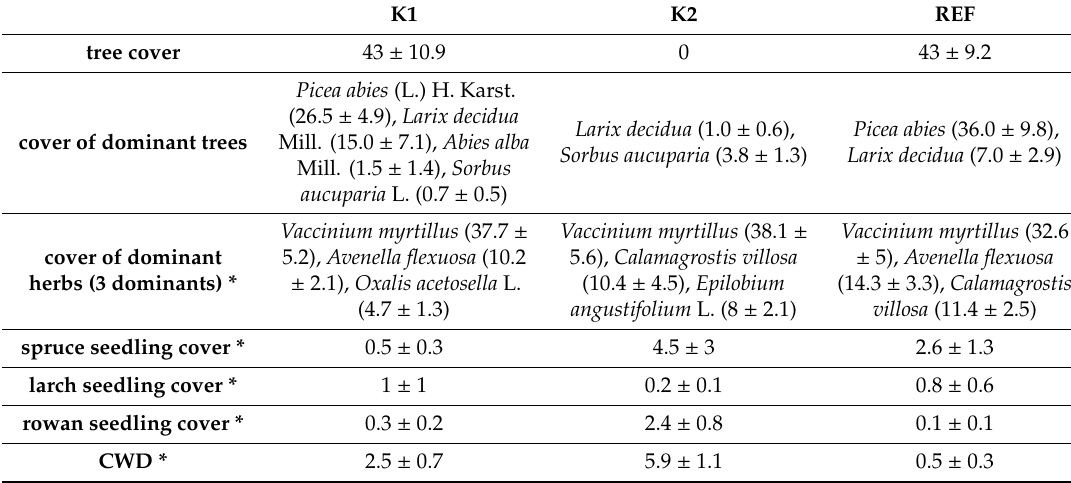
Table 1. Mean cover of trees, tree species composition, herb composition, tree regeneration, and coarse woody debris (CWD) in the K1 forest attacked by bark beetle, K2 forest destroyed by bark beetle, and REF mature forest.